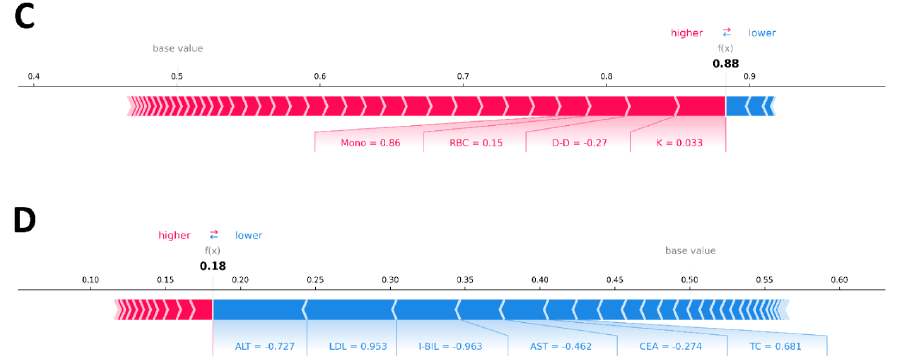
Figure 4. SHAP plot of the RF model: ( A ) SHAP summary plot of the top 40 features of the RF model; ( B ) SHAP decision plot of the top 40 features of the RF model; ( C ) SHAP force plot for the explanation of the model prediction results with a response sample from the testing set; ( D ) SHAP force plot for the explanation of the model prediction results with a nonresponse sample from the testing set. LDL, low-density lipoprotein; ALT, alanine aminotransferase; RBC, red blood cell; D-D, d-dimer; ALB, albumin; TC, total cholesterol; TG, triglyceride; Mono, monocyte; LMR, lymphocyte monocyte ratio; BMI, body mass index; I-BIL, indirect bilirubin; AST, aspartate aminotransferase; APTT, activated partial thromboplastin time; INR, international normalized ratio; PT, prothrombin time; ALBI, albumin–bilirubin; T-BIL, total bilirubin; CEA, carcinoembryonic antigen; Hb, hemoglobin; A/G, albumin/globulin; GLOB, globulin; FIB, fibrinogen; HDL, high-density lipoprotein; γ -GTP, γ -glutamyl transpeptidase; PLT, platelet; TP, total protein; NLR, neutrophil lymphocyte ratio; AFP, alpha fetoprotein; Lymph, lymphocyte; BUN, blood urea nitrogen; PLR, platelet lymphocyte ratio; Neut, neutrophil; CA19-9, carbohydrate antigen 19-9; ALP, alkaline phosphatase; Scr, serum creatinine; WBC, white blood cell; SHAP, Shapley Additive